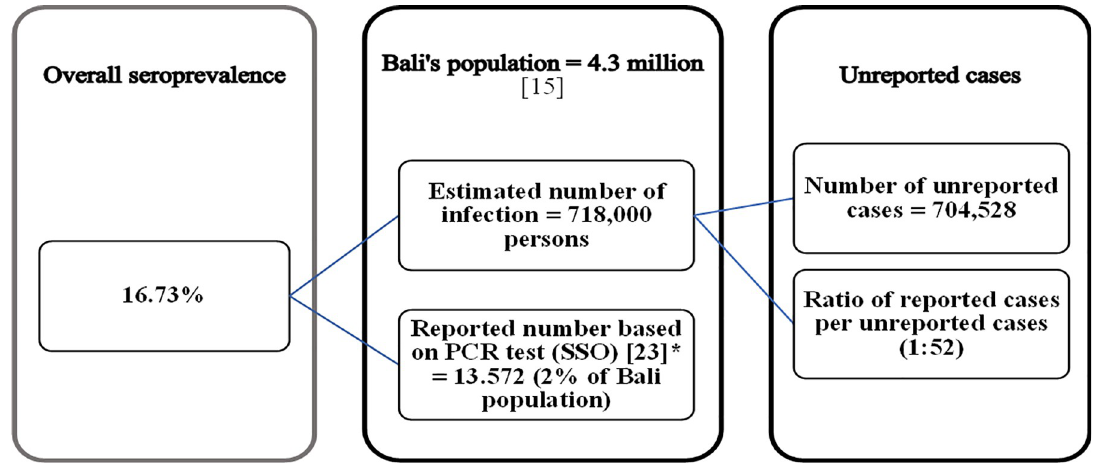
Fig 1. Comparison of reported case and estimated cases of SARS-CoV-2 infection based on serosurvey results.